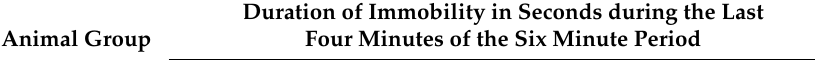
Table 1. Effects on Immobility Duration.